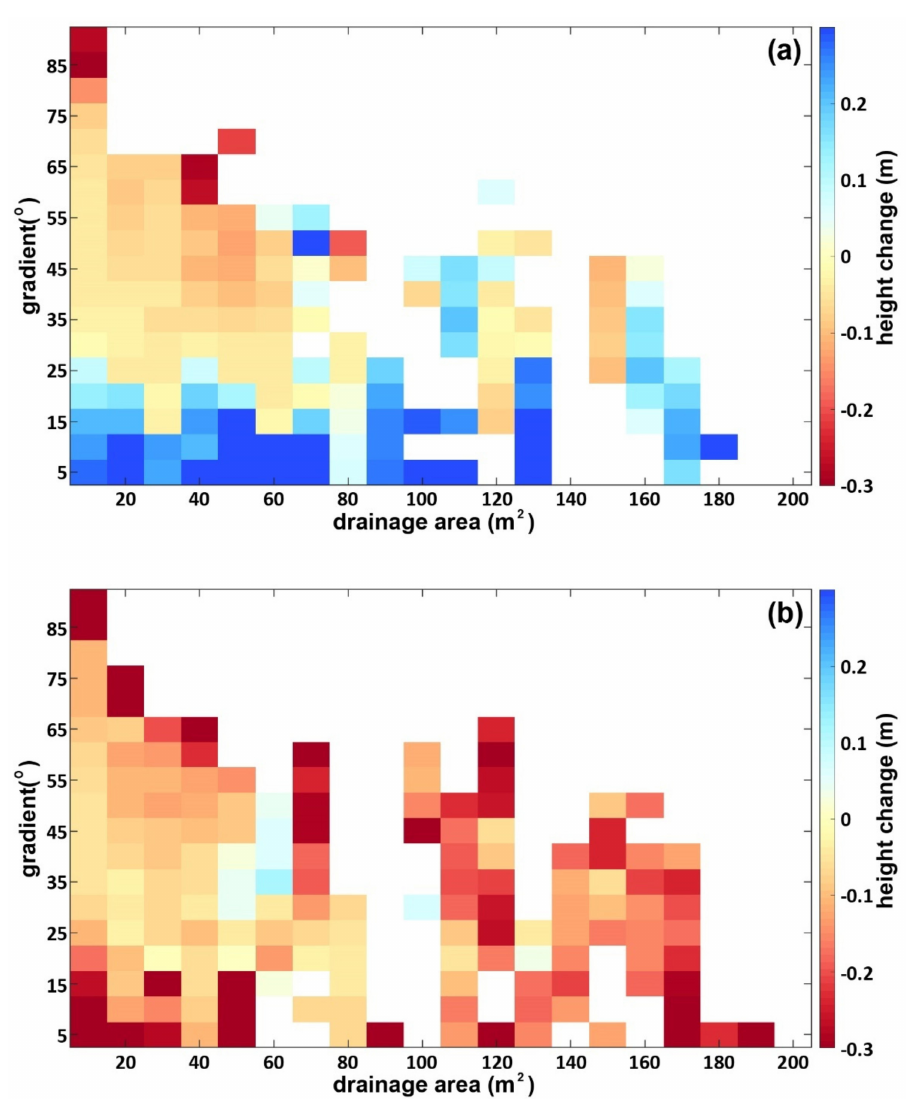
Figure 4. Relationship among the hillslope gradient, height change, and drainage area. The subpanels indicate the following: ( a ) 24 February–26 May 2011, representing the first period; ( b ) 26 May–3 August 2011, representing the second